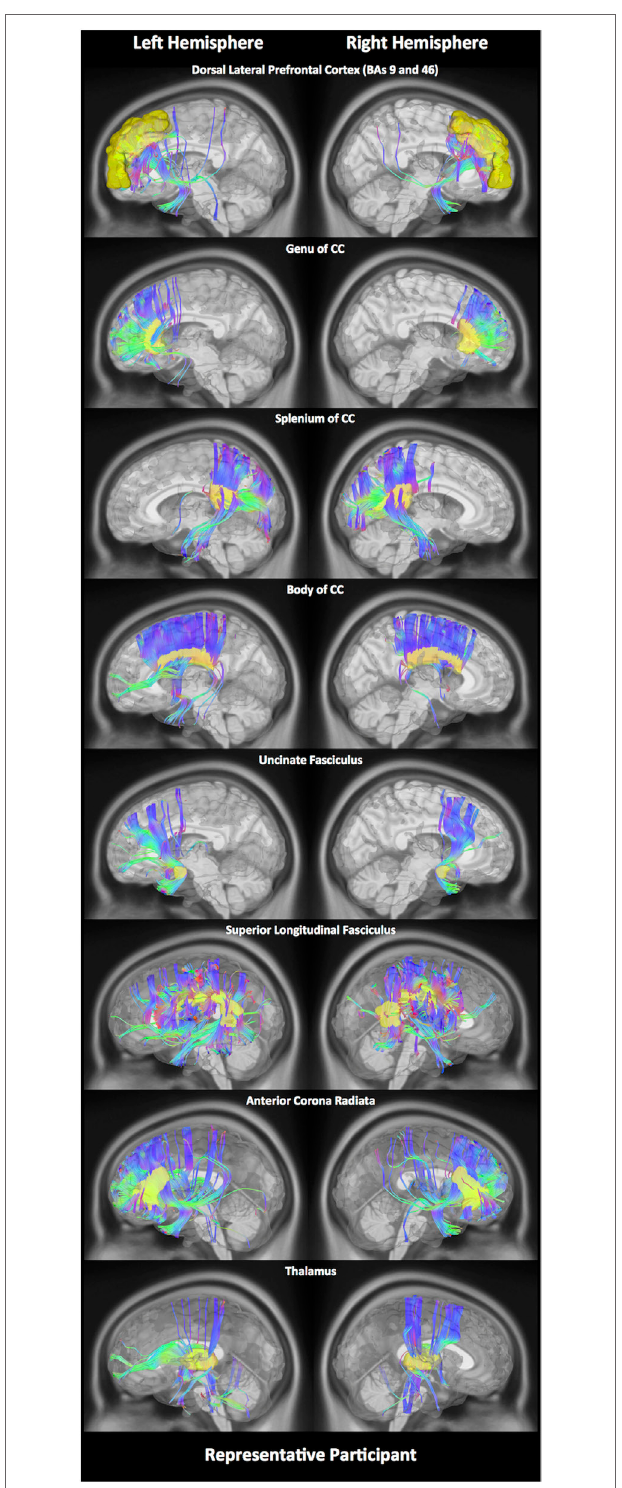
FigUre 1 | White matter fiber tracking. Here, for a representative participant, we illustrate white matter fiber tracts for each of the 11 regions. Tracts shown in red indicate a fiber direction from left to right or vice versa . Blue indicates a fiber direction from anterior to posterior or vice versa . Green indicates a fiber direction from superior to inferior or vice versa